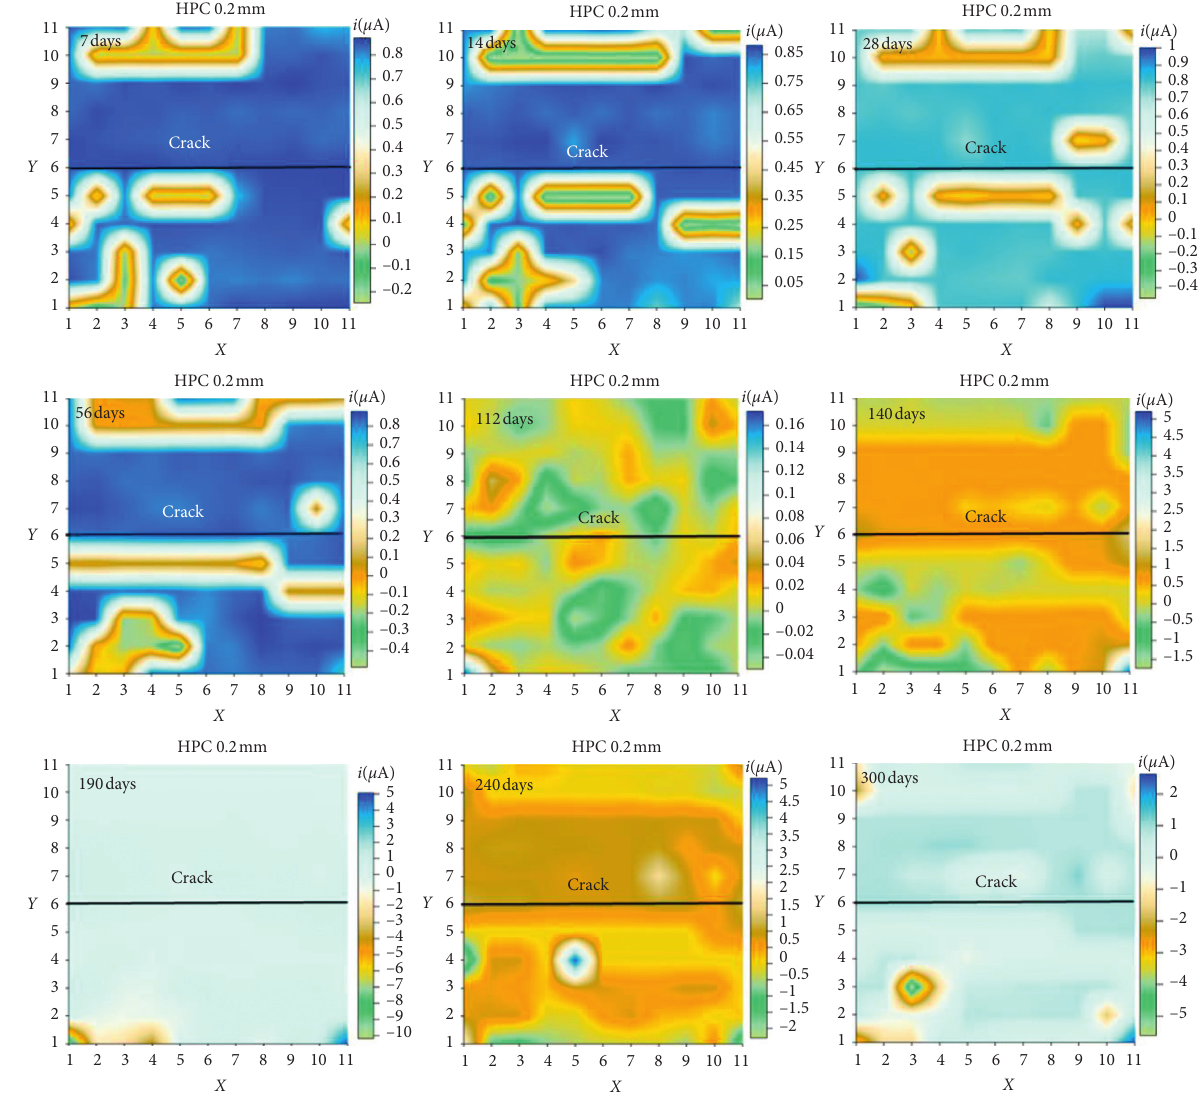
Figure 17: Current distribution of WBE protected by HPC mortar with 0.2 mm